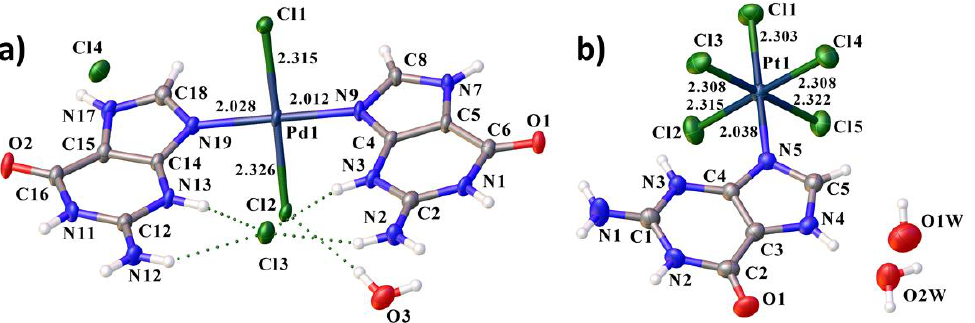
Figure 1. Asymmetric fragments of 1 ( a ) and 2 ( b ) with labeling of atoms and some bond lengths. Displacement ellipsoids are drawn at the 50% probability level.